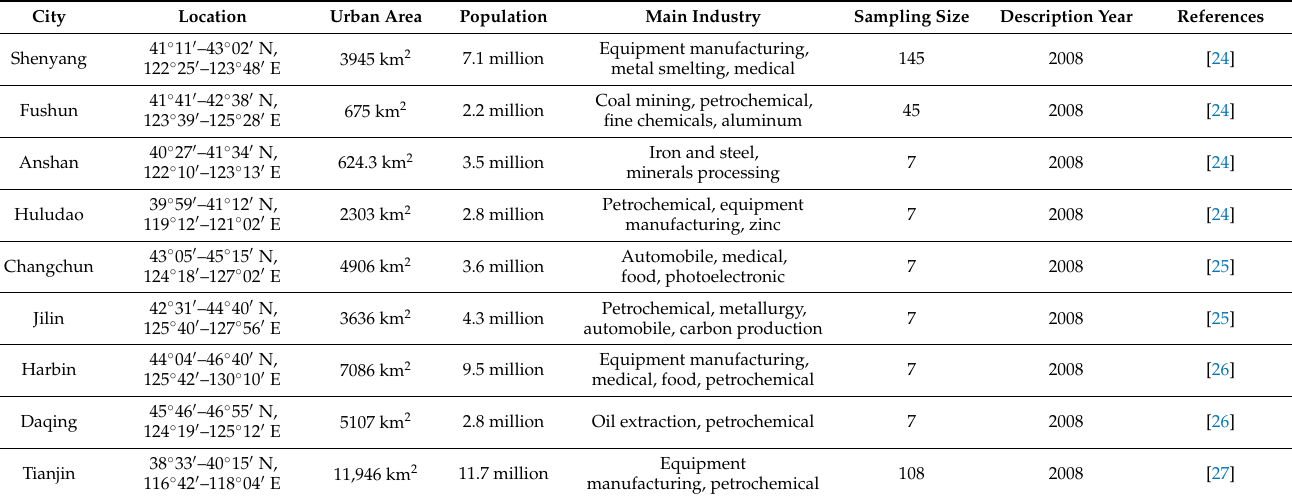
Table 1. Description of the nine cities examined in this